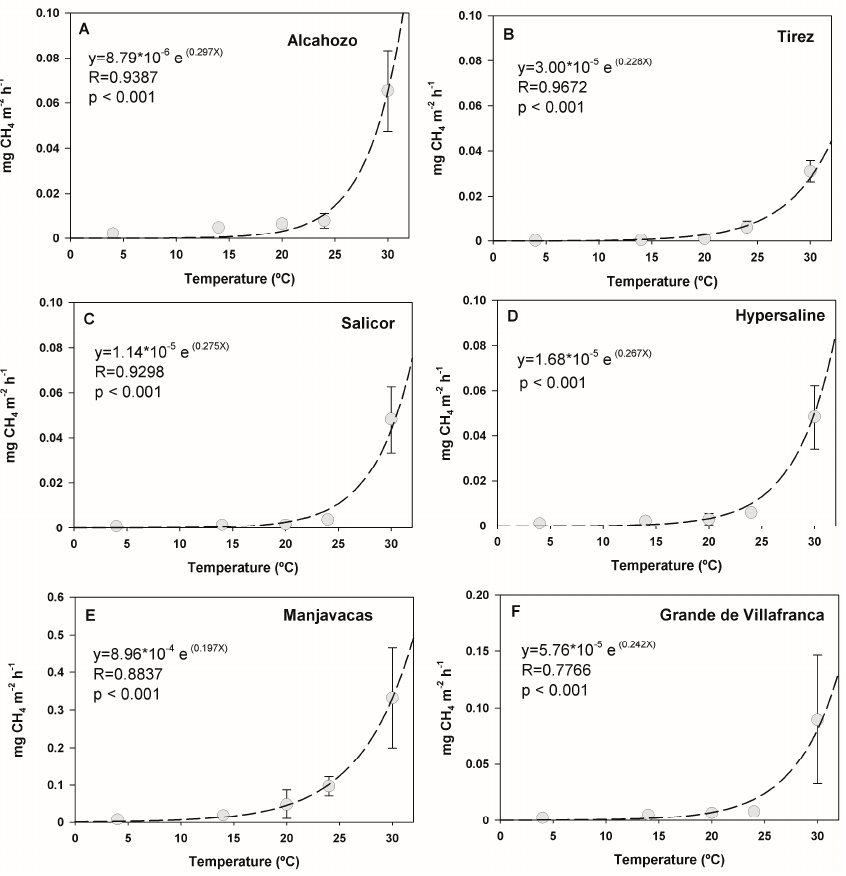
Figure 3. Changes in methane release rates vs. temperature in the range 4–30 °C for the studied lakes. Bars represent the standard deviation.